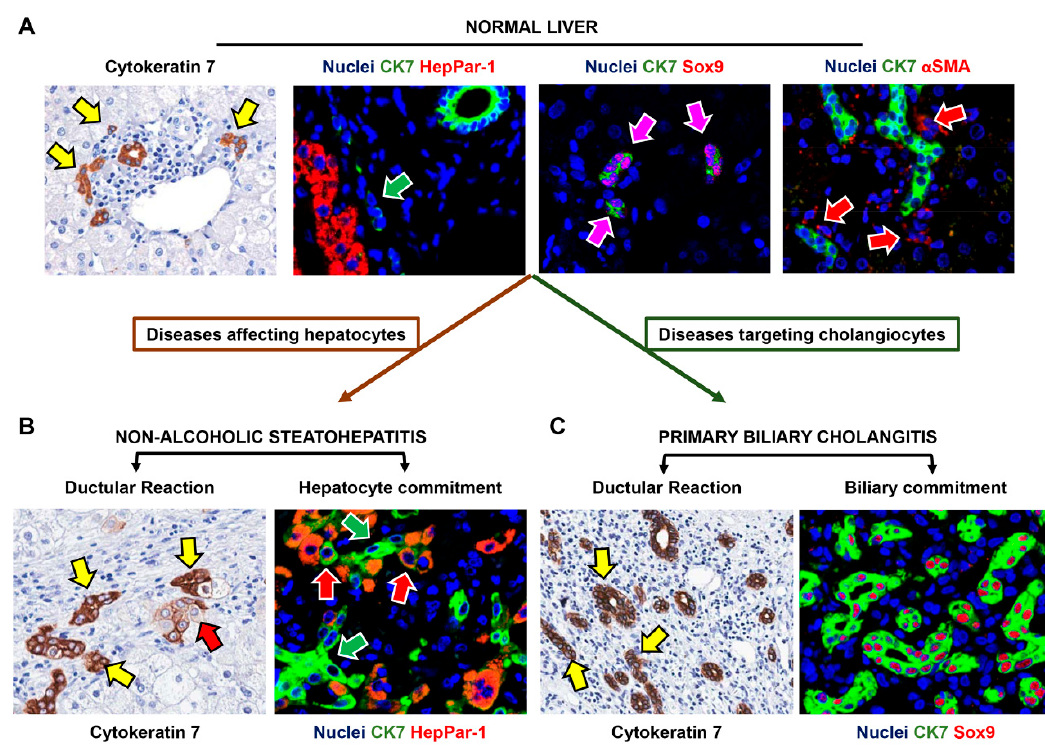
Figure 2. Hepatic Stem/progenitor Cell (HpSC) phenotype in normal liver and in pathological conditions. In normal liver ( A ), HpSC are recognizable (yellow arrows) thanks to the expression of cytokeratin 7 (CK7) and are located at the interface with hepatocyte plate as showed in double immunofluorescence (green arrows) with hepatocyte marker (HepPar-1). HpSCs express the stem cell marker Sox9 (purple arrows) and are surrounded by α -Smooth Muscle Actin ( α SMA)+ myofibroblast-like cells (red arrows). In human disease affecting hepatocytes ( B ) as in non-alcoholic steatohepatitis, activation of HpSCs determines the appearance of ductular reaction (DR) with signs of hepatocyte commitment. In immunohistochemistry for CK7, DR (yellow arrows) is in close connection with hepatocyte plate and intermediate hepatocytes are present (red arrows); in double immunofluorescence, DR (green arrows) contains cells expressing HepPar-1 (red arrows). In diseases targeting cholangiocytes ( C ) as in primary biliary cholangitis, DR is prominent, located inside fibrotic septa (arrows), and composed of cells with an undifferentiated (Sox9)/biliary (CK7) phenotype.